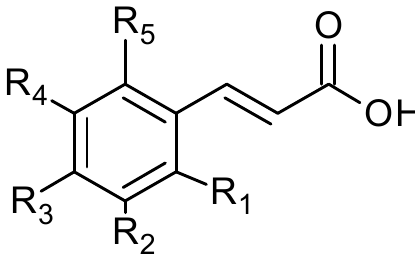
Figure 16. Hydroxycinnamic acid derivatives. Table 8 . Hydroxycinnamic acid derivatives.